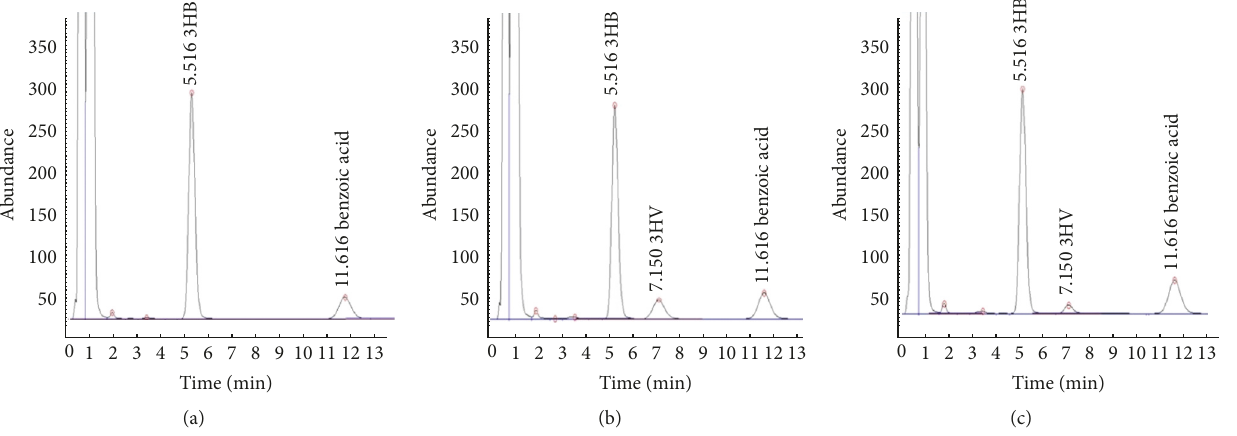
Figure 3: Chromatogram obtained from gas chromatography (GC) of (a) poly(3-hydroxybutyrate) (PHB) standard, (b) poly(hydroxybutyrate-co-hydroxyvalerate) (PHBV) standard with 12mol% HV content, and (c) polymer produced from 20% v/v of avocado oil (7 mol% of HV). Benzoic acid was used as internal